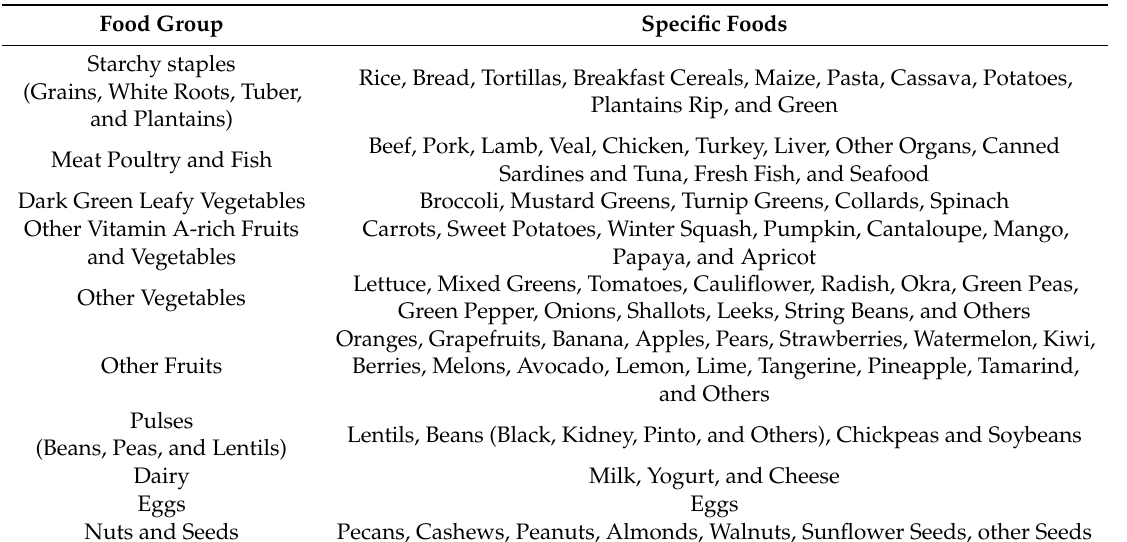
Table 1. Food groups included in the minimum Dietary Diversity